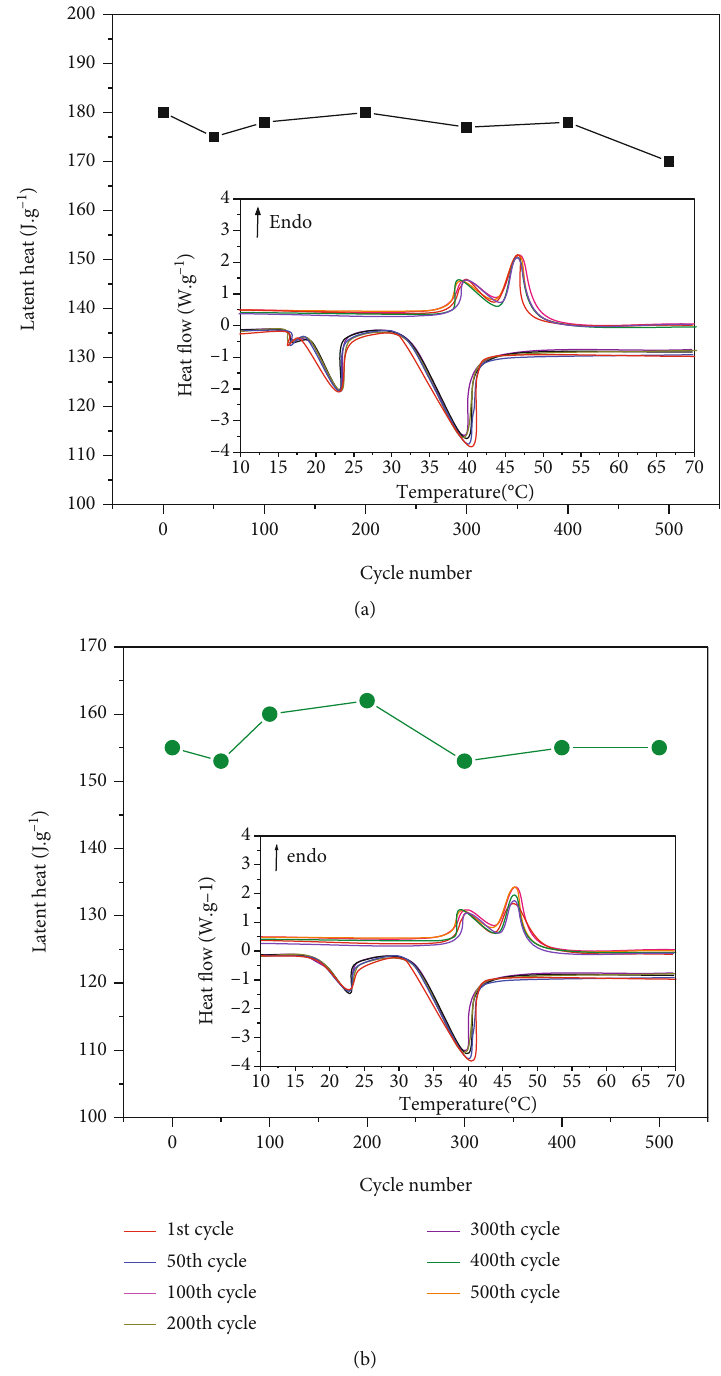
Figure 3: The next 500 thermal cycles and the latent heat of the microencapsulated phase-change materials. (a) 0.0 and (b)